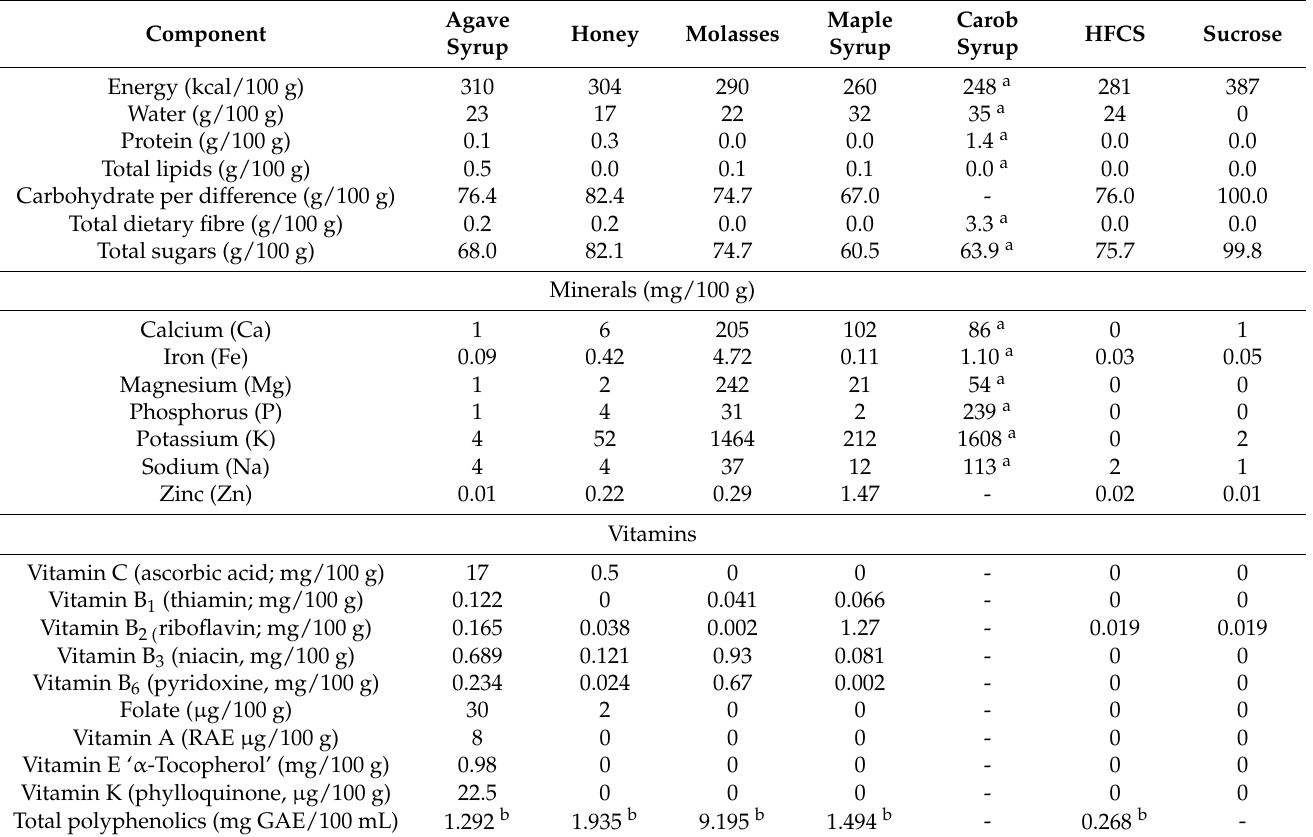
Table 2. The typical total phenolic and nutrient composition of traditional common sweeteners (adapted with permission from Edwards et al., 2016, Elsevier) [64] 1